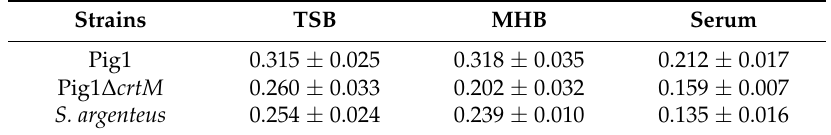
Table 5. Membrane anisotropy values 1 of S. aureus strains grown to log phase 2 in various media. Strains TSB MHB Serum Pig1 0.315 ± 0.025